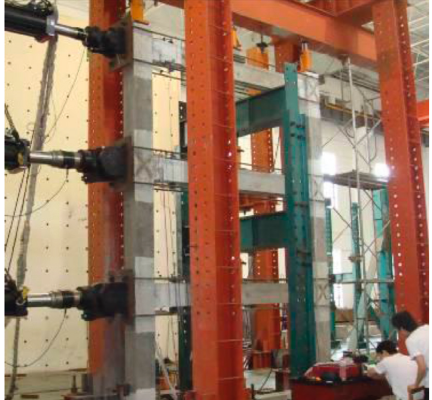
Figure 2: The seismic testing of the single-span three-story pre- stressed fabricated concrete